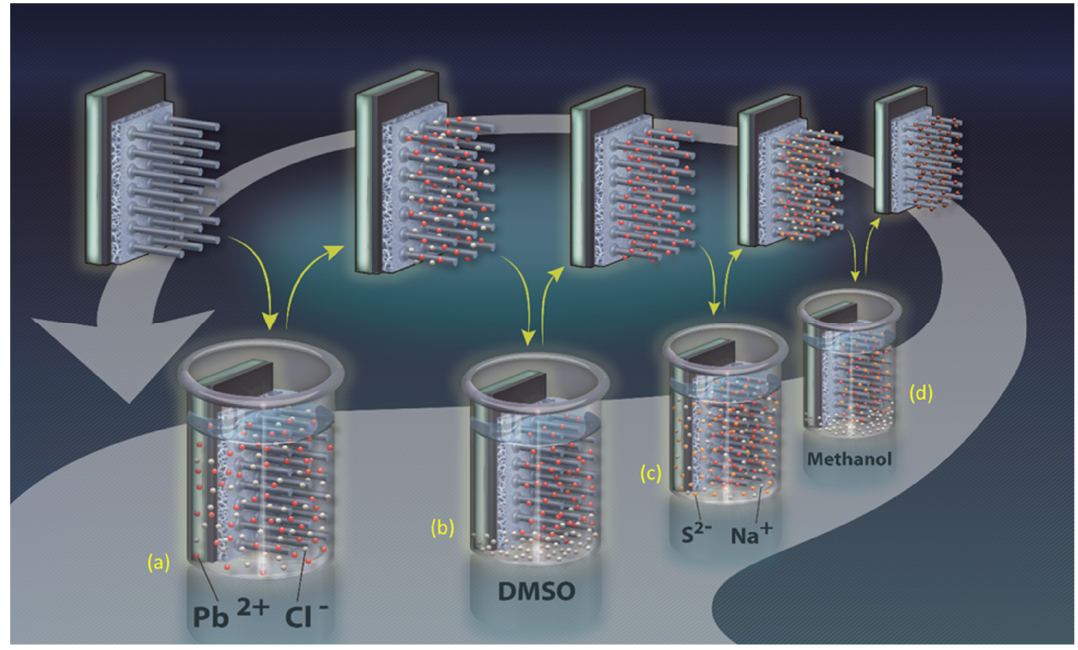
Figure 4. The scheme of PbS thin-film deposition ( ○ Pb 2+ ; ● S 2– ) by SILAR: ( a ) Pb 2+ cationic precursor, ( b ) ion exchange water, ( c ) S 2- anionic precursor and ( d ) ion exchange water.